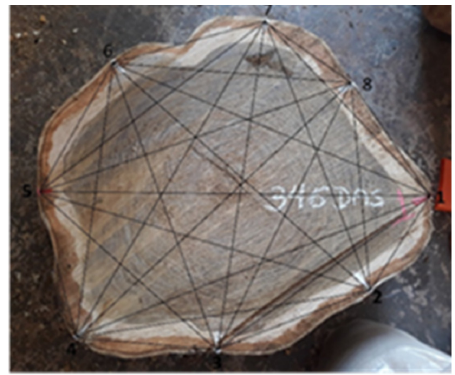
Figure 6. Example of theoretical routes of the projected measurement mesh on the face of the